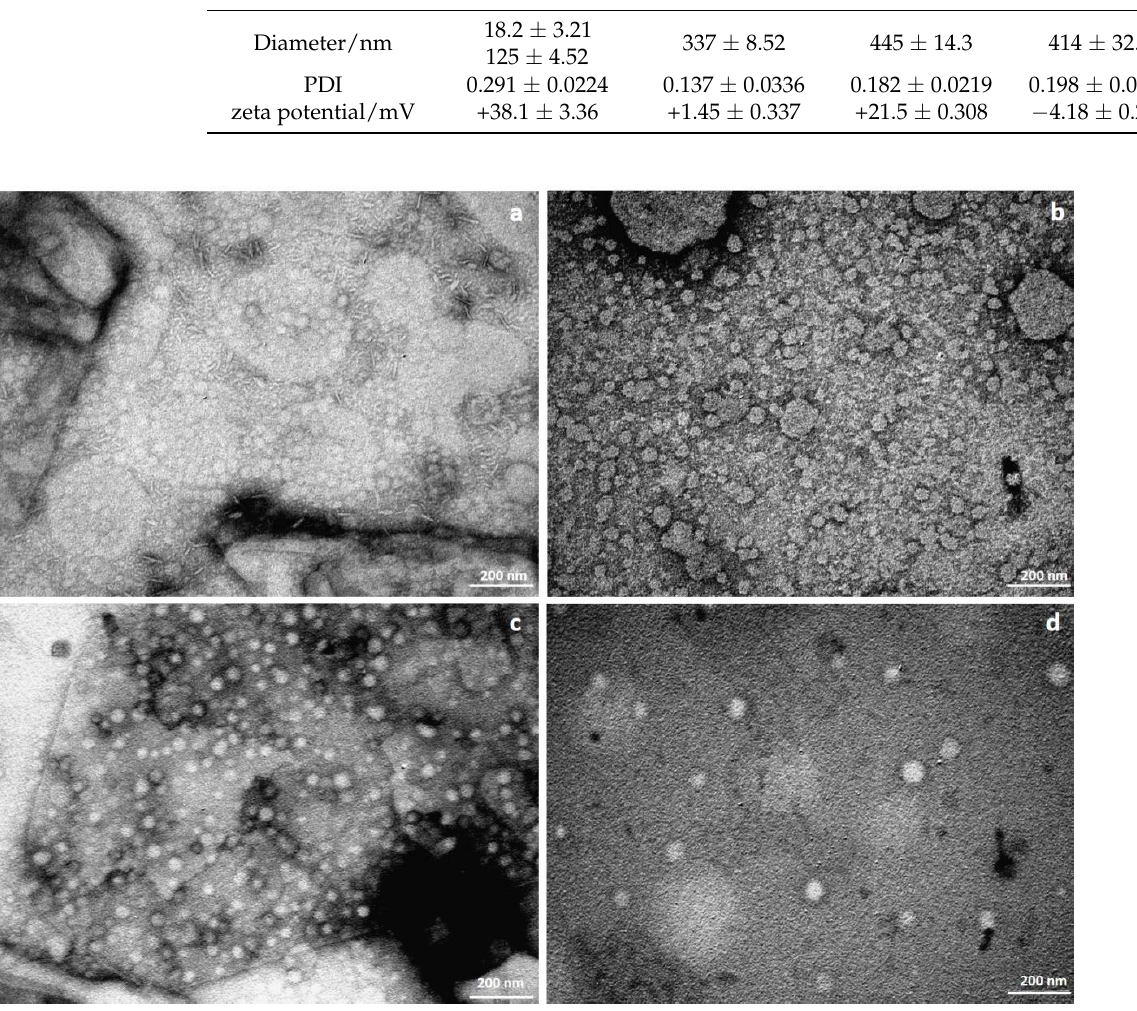
Figure 4. TEM images of SLN. SLN suspensions were contrasted with uranyl acetate and washed in ultra-pure water before visualization. Scale bar = 200 nm ( a ) SLN-AP 3% Pluronic; ( b ) blank SLN 3% Pluronic; ( c ) SLN-AP 10% Pluronic; and ( d ) blank SLN 10% Pluronic.